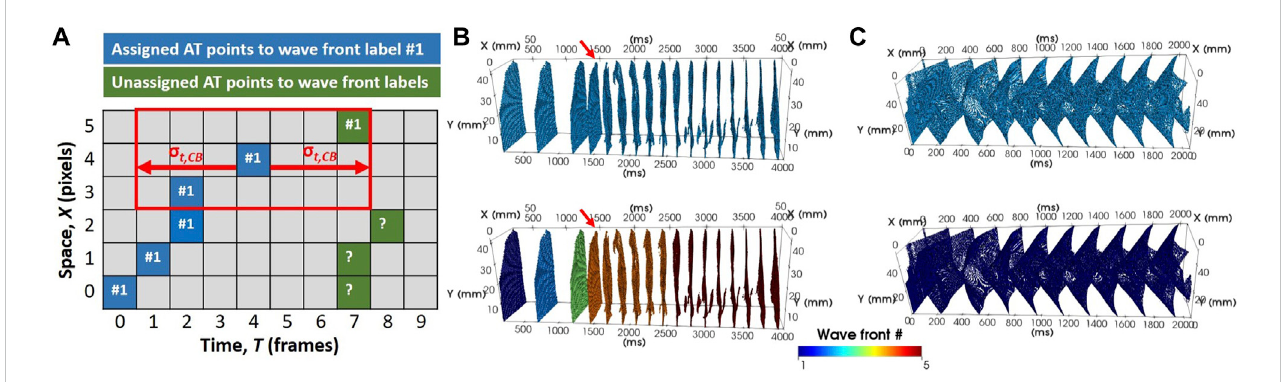
FIGURE 4 Adaptedconnectedcomponentsalgorithmforwavefrontclustering. (A) AschematicdiagramillustratespATpointsonaspace-timeplot.Intheexample, wavefrontlabelassignmenthasbeenmadeforallpATpointsinthe fi rst4framestolabel#1.LetthecurrentpATpointbeevaluatedforconnectivitybeatpixel 4, frame 4 on the space-time plot. The red box illustrates the space-time bounds of eligible connectivity. In this case, the currently unassigned pAT point at pixel 5, frame 7 lies within the connectivity boundary and will be assigned to wave front label #1. (B) A spatio-temporal distribution of pAT points for the fi rst4 sofpacing andreentryinductioninexperiments(upper panel).pAT pointsareassigned colorsbased ontheirwavefrontlabelassignment(lowerpanel). (C) Similarly, pAT points of the in silico model from the moment of reentry induction (upper panel) and wave front label assignment (lower